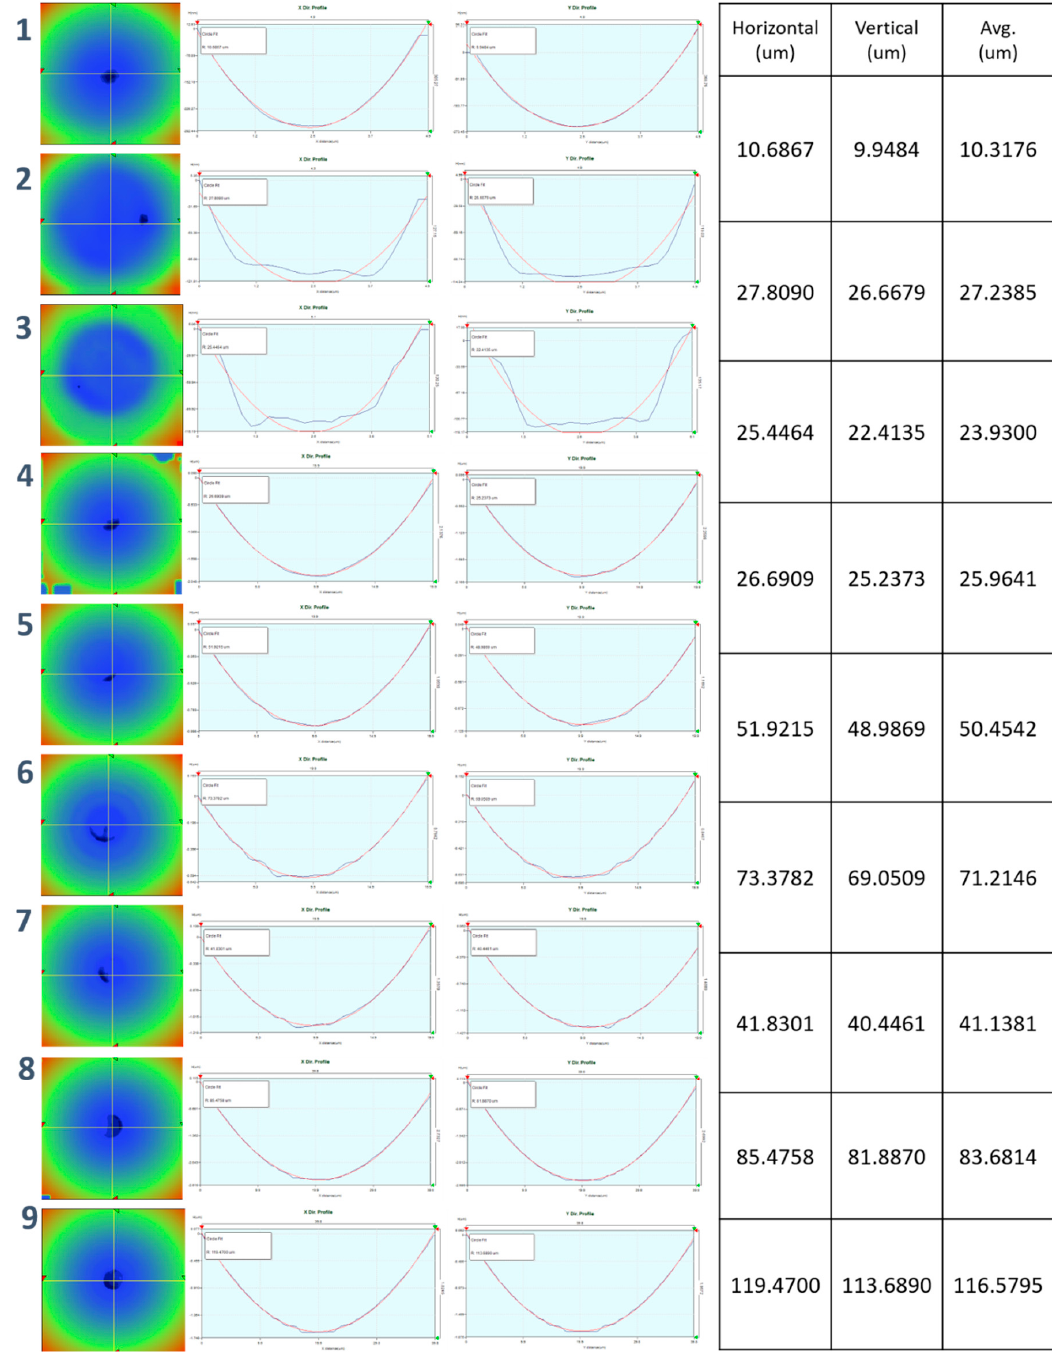
Figure A14. ROC measurement data for 3rd WSM replica.